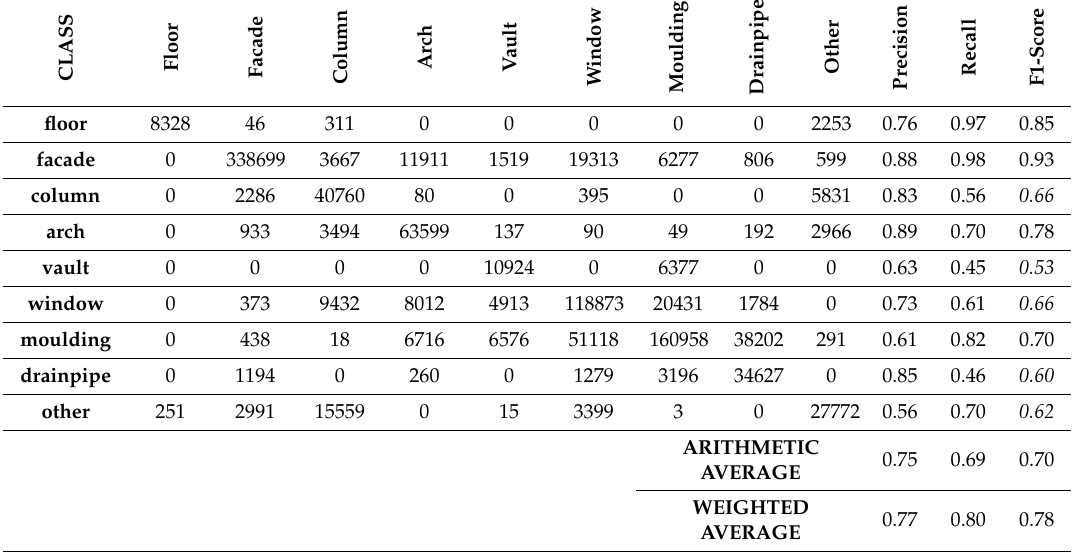
Table 6. Evaluation metrics: generalisation level #3, dataset E. The most critical F1 values are reported in italics.